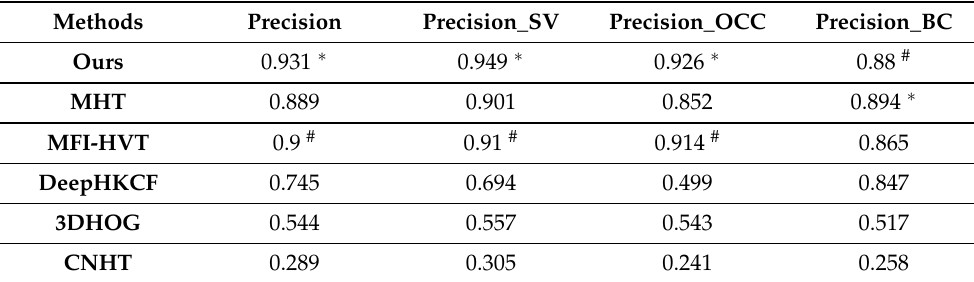
Table 2. The details of precision results. The suffixes mean that the measurements are only counted in the sequences with the corresponding challenges. The best and the second best results are marked by symbols * and #, respectively.